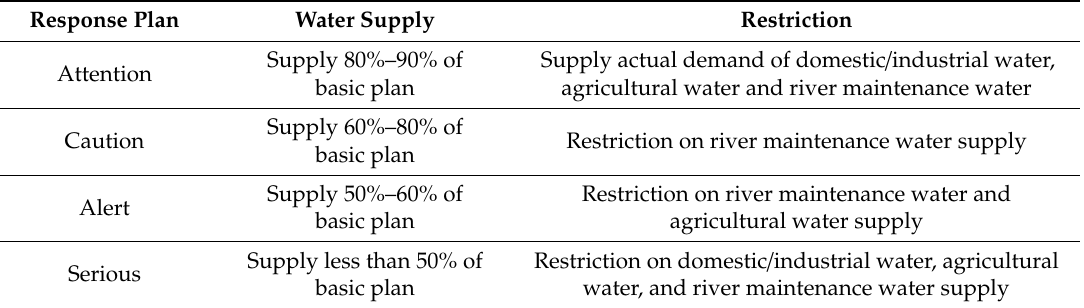
Table 6. The dam water supply plan when reservoir storage is under drought conditions.